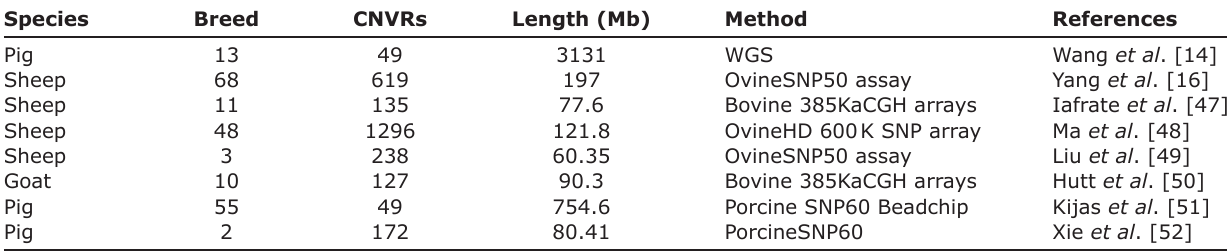
variation regions Table-2: CNVs detection studies in domestic animals.